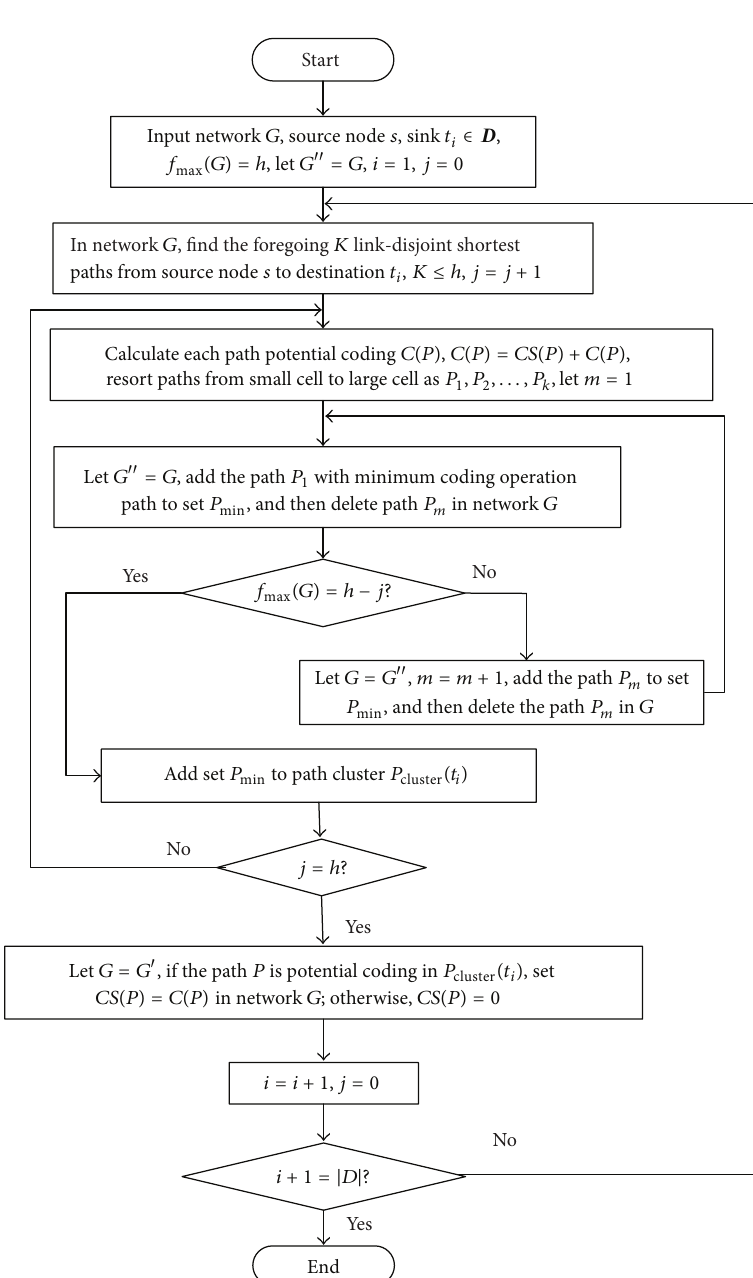
Figure 1: Chart of MR-MNCO